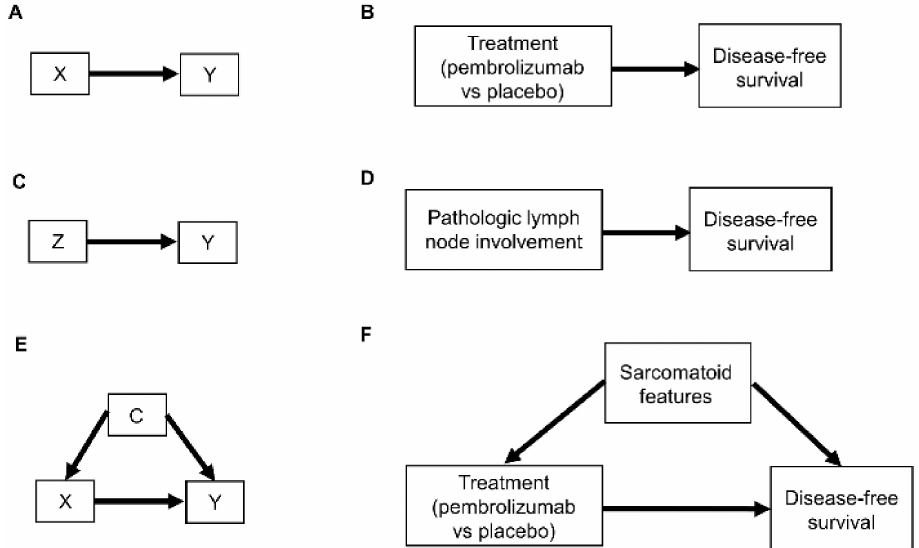
Figure 1. Examples of causal relationships represented by DAGs: ( A ) A simple scenario whereby the treatment choice X (also known as “exposure”) directly influences the outcome of interest Y; ( B ) Corresponding simple clinical scenario whereby the treatment choice between adjuvant pem- brolizumab or placebo directly influences the outcome of disease recurrence or death measured by DFS; ( C ) Simple scenario whereby a prognostic variable Z directly influences the outcome Y; ( D ) Corresponding clinical scenario whereby the presence or absence of pathologic lymph node involvement directly influences DFS; ( E ) Scenario whereby a confounder C directly influences both the treatment choice X and the outcome Y; ( F ) Corresponding clinical scenario whereby the presence or absence of sarcomatoid features acts as a confounder by influencing treatment choice and